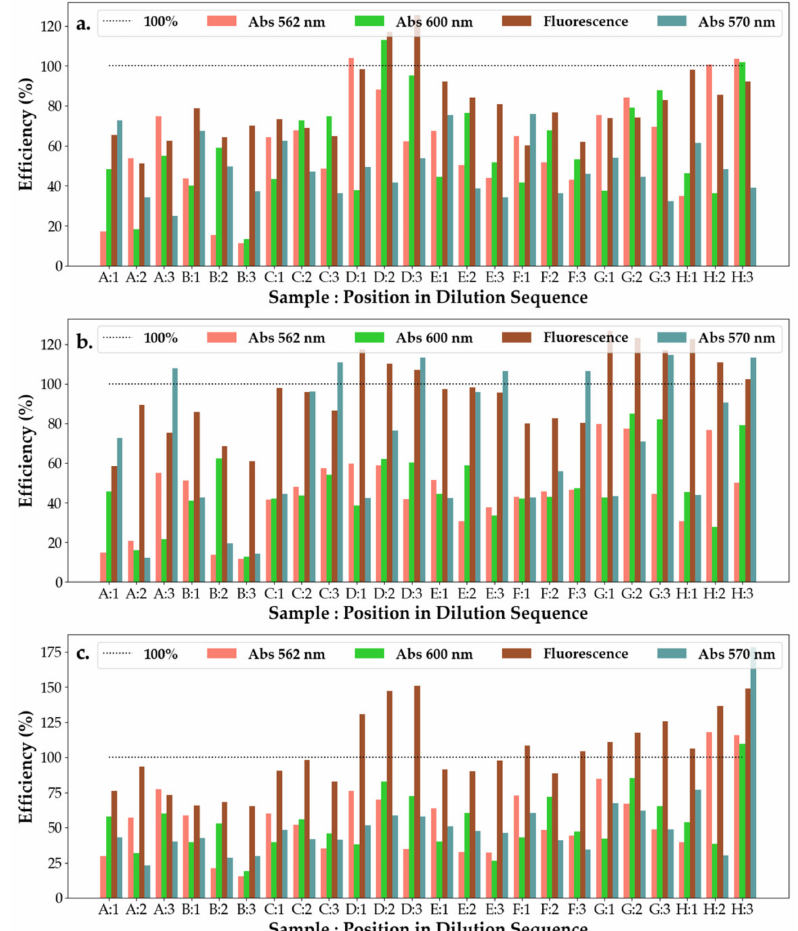
Figure 11. Efficiency of the antibacterial response ( η ) of the SAgNPs-WT ointment samples at three levels of dilution tested against ( a ) Escherichia coli , ( b ) Pseudomonas aeruginosa and ( c ) Staphylococcus aureus . Samples A–H represent the following solutions tested against the bacteria: A—Tween 20; B—Ont 1 + SAgNPs-WT 10S + 1% tween 20; C—Ont 1 + SAgNPs-WT 10S + 1% tween 20 (1:1:1); D—Ont 1 + SAgNPs-WT 10S + 1% tween 80 (1:1:1); E—Ont 2 + SAgNPs-WT 10S + 1% tween 80; F—Ont 2 + SAgNPs-WT 10S + 1% tween 20 (1:1:1); G—Ont 2 + SAgNPs-WT 10S + 1% tween 80